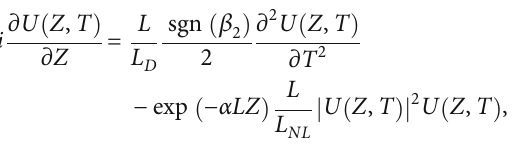
Figure 7: A comparison of the split-step Fourier transform (SSFT) approximate solutions at a higher value of GVD of β lossless (a) and lossy optical fi ber (b) when the input pulse is a bright soliton at distances z = 0 : 1, 1, 10 km,